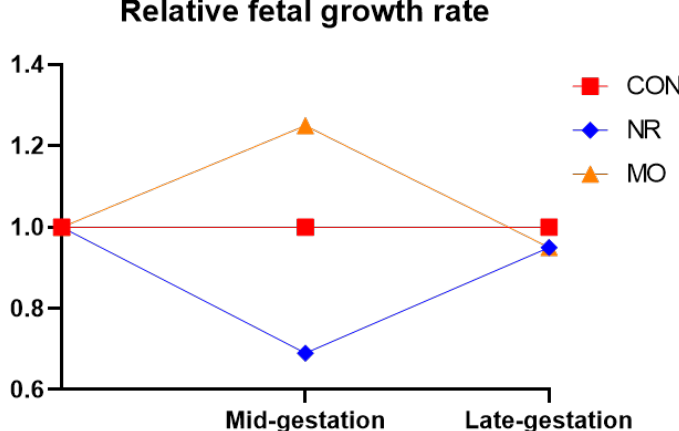
Figure 1. Relative fetal growth rate at mid-gestation (day 75, term = 150 d) and late gestation (day 135)